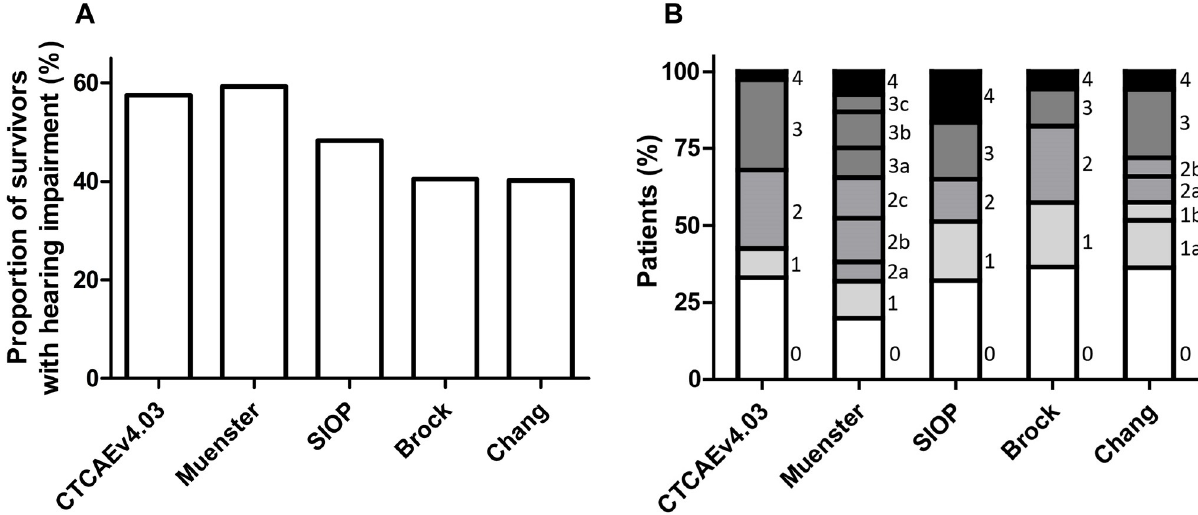
Fig 1. Prevalence of deleterious hearing loss (A) based on CTCAEv4.03 � grade 2, Muenster � grade 2b, SIOP � grade 2, Brock � grade 2 and Chang � grade 2a, and ototoxicity grade distribution (B) according to the last available